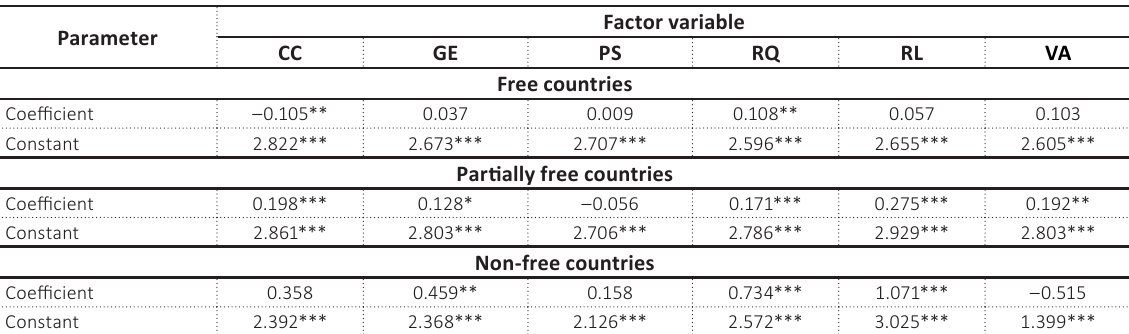
Table 4. The influence of governance quality on the level of independence of central banks among the countries with different levels of political rights